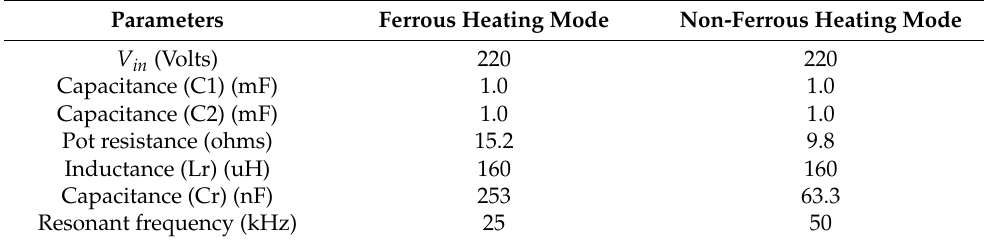
Table 1. Circuit parameters for different modes of operation.